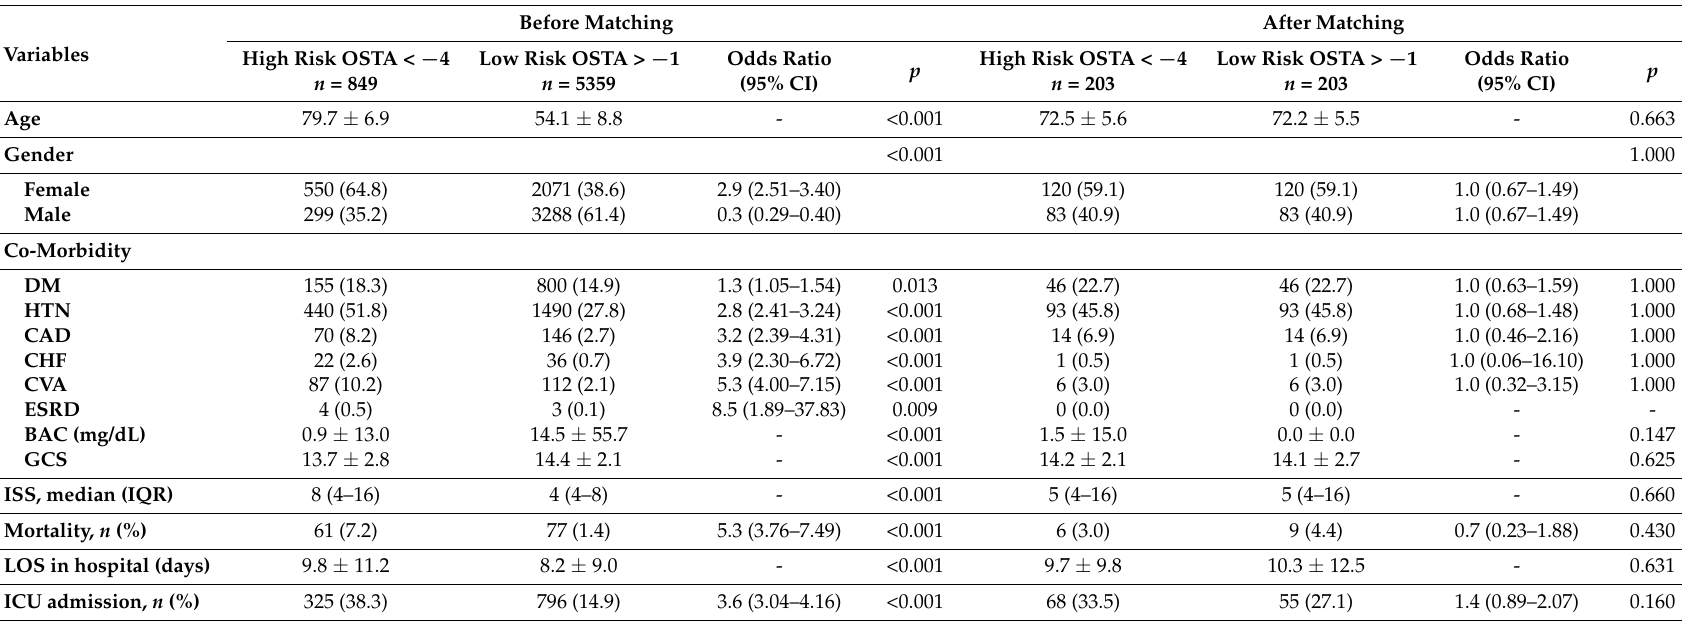
Table 7. Outcome of the high-risk and low-risk patients before and after propensity score-matching with adjustment of the covariates including age and other variables.